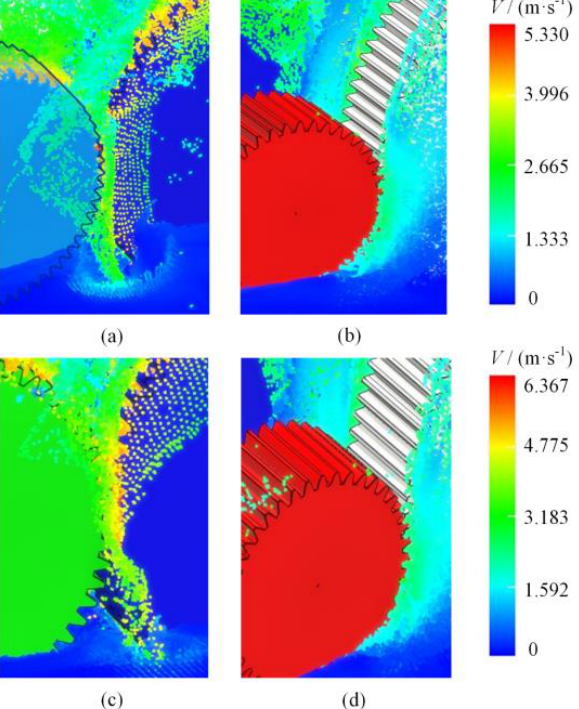
Figure 4. The oil distribution cloud diagram of the gear meshing area during lubrication. ( a ) t = 0.04 s; ( b ) t = 0.04 s; ( c ) t = 0.06 s; ( d ) t = 0.06 s.